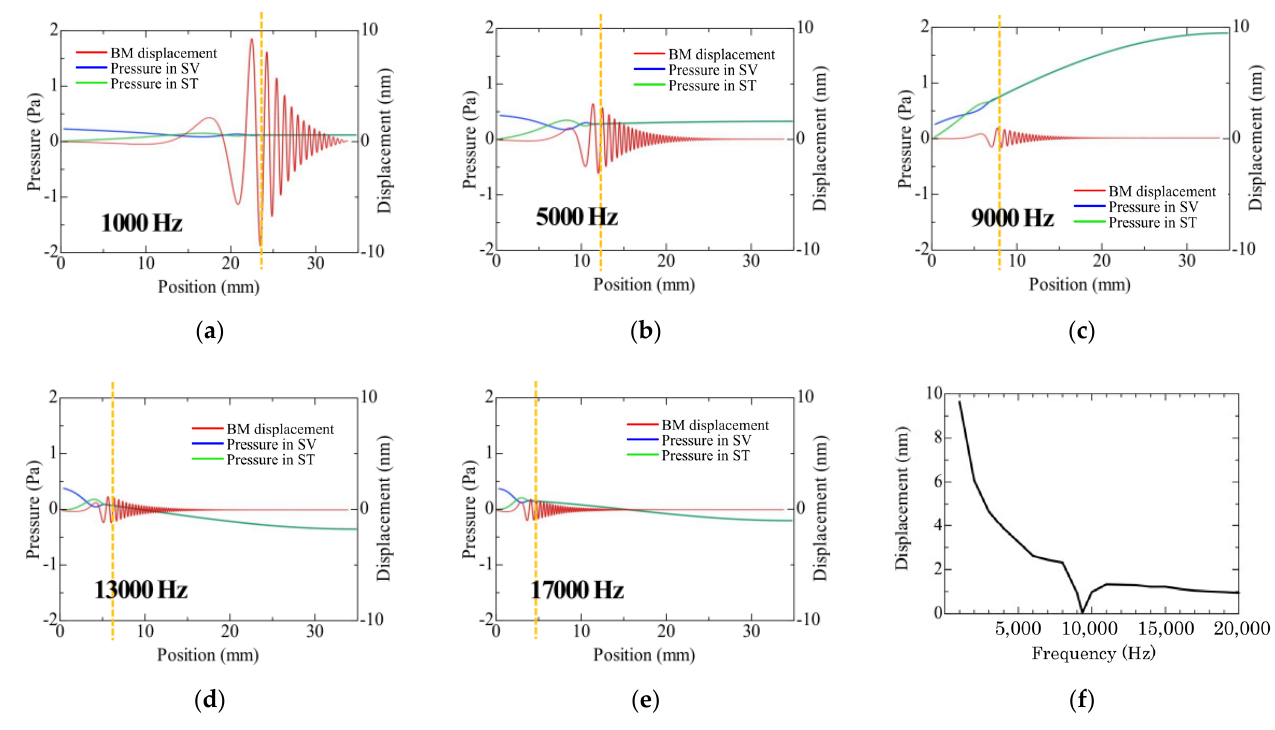
Figure 2. ( a – e ) Frequency domain analyses of the sound pressure level (SPL) of the SV (blue) and ST (green), and the displacement of the BM (red) when the OW plane is excited by a 1 Pa sinusoidal sound wave. The horizontal axis shows the internal position of the cochlea. ( f ) Frequency characteristic of the maximum displacement of the BM, extracted from the maximum displacements of the BM such as those in ( a – e ).